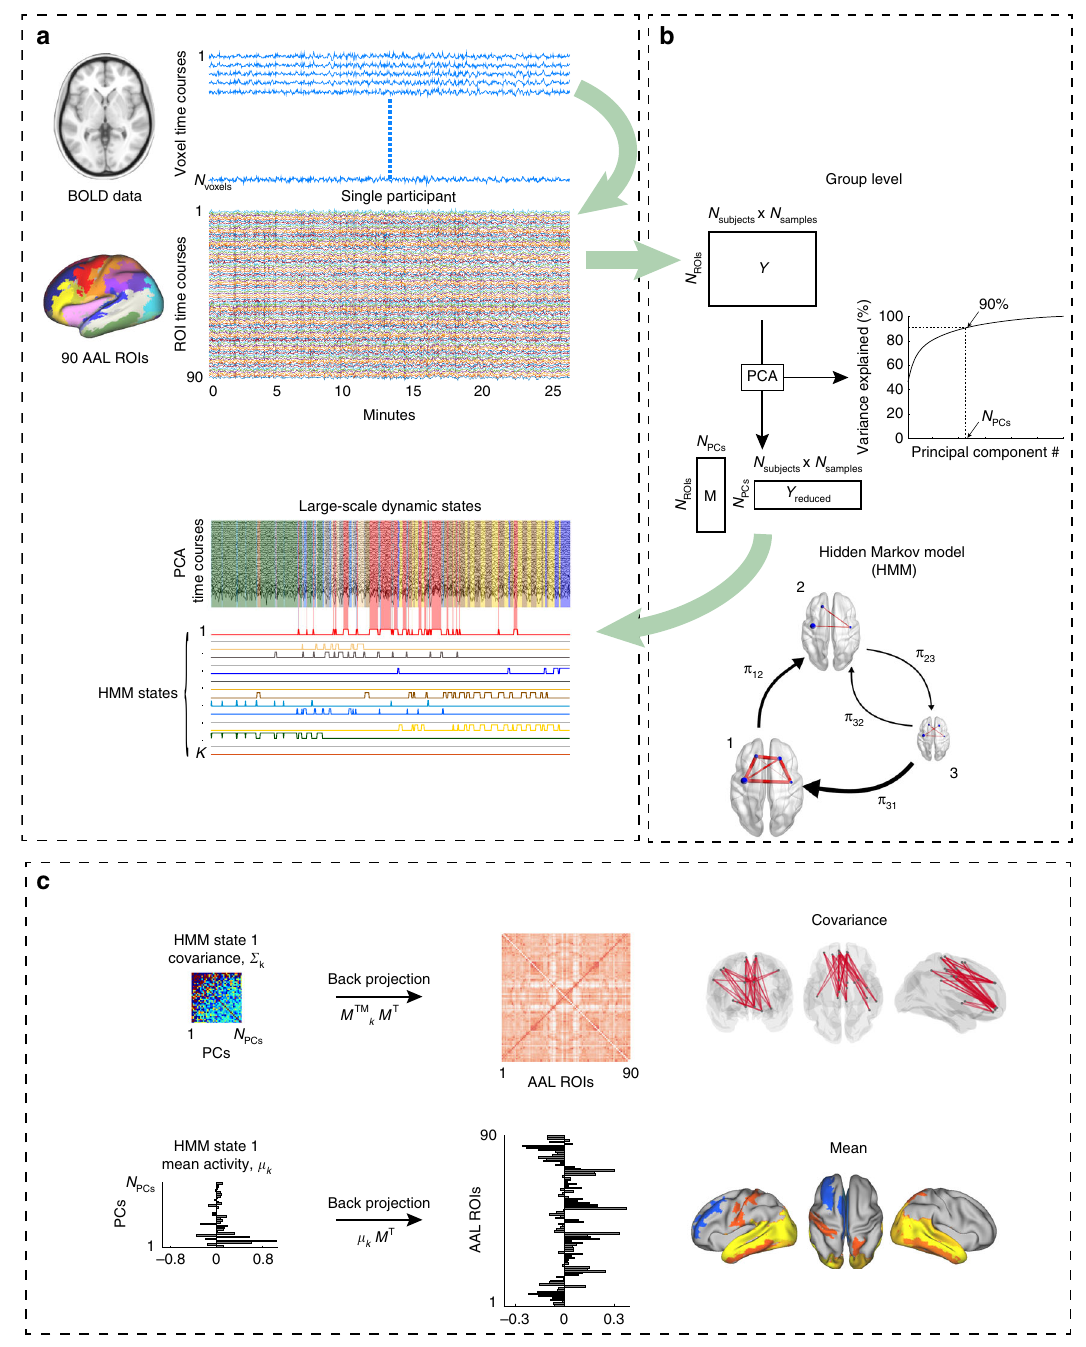
Fig. 1 Dynamic whole-brain networks from fMRI sleep recordings using a Hidden Markov Model. a ROI timecourses were extracted by averaging BOLD signals across voxels within each of the 90 cortical and subcortical AAL areas for each participant. Each ROI timecourse was demeaned and normalised by its standard deviation. b The data were concatenated across participants, and the dimensionality was reduced using PCA (principal component analysis), such that ~90% of the variance of the ROI timecourses was retained. The HMM was run on the PCA timecourses, resulting in K number of states with associated timecourses, each describing the points in time each state is active and inactive. c Each HMM state was characterised by a multivariate Gaussian distribution comprising a covariance matrix, Σ K , and a mean distribution, μ K . The state-speci fi c mean distributions and covariance matrices were back-projected to the MNI space of the AAL by using the mixing matrix, M T from the PCA decomposition, yielding a mean activation map and an FC matrix for each HMM